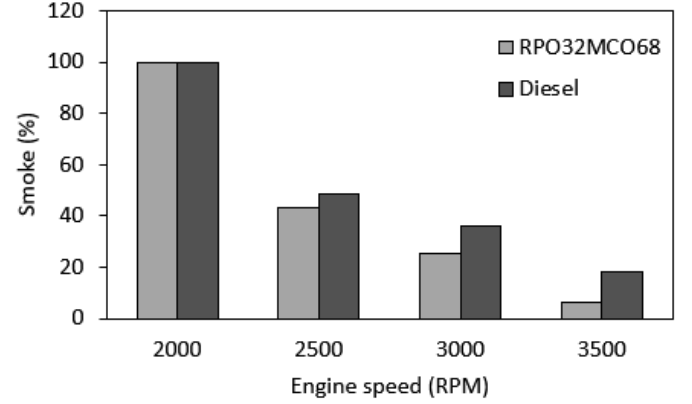
Figure 16. Comparison of smoke opacity as a function of engine speeds.